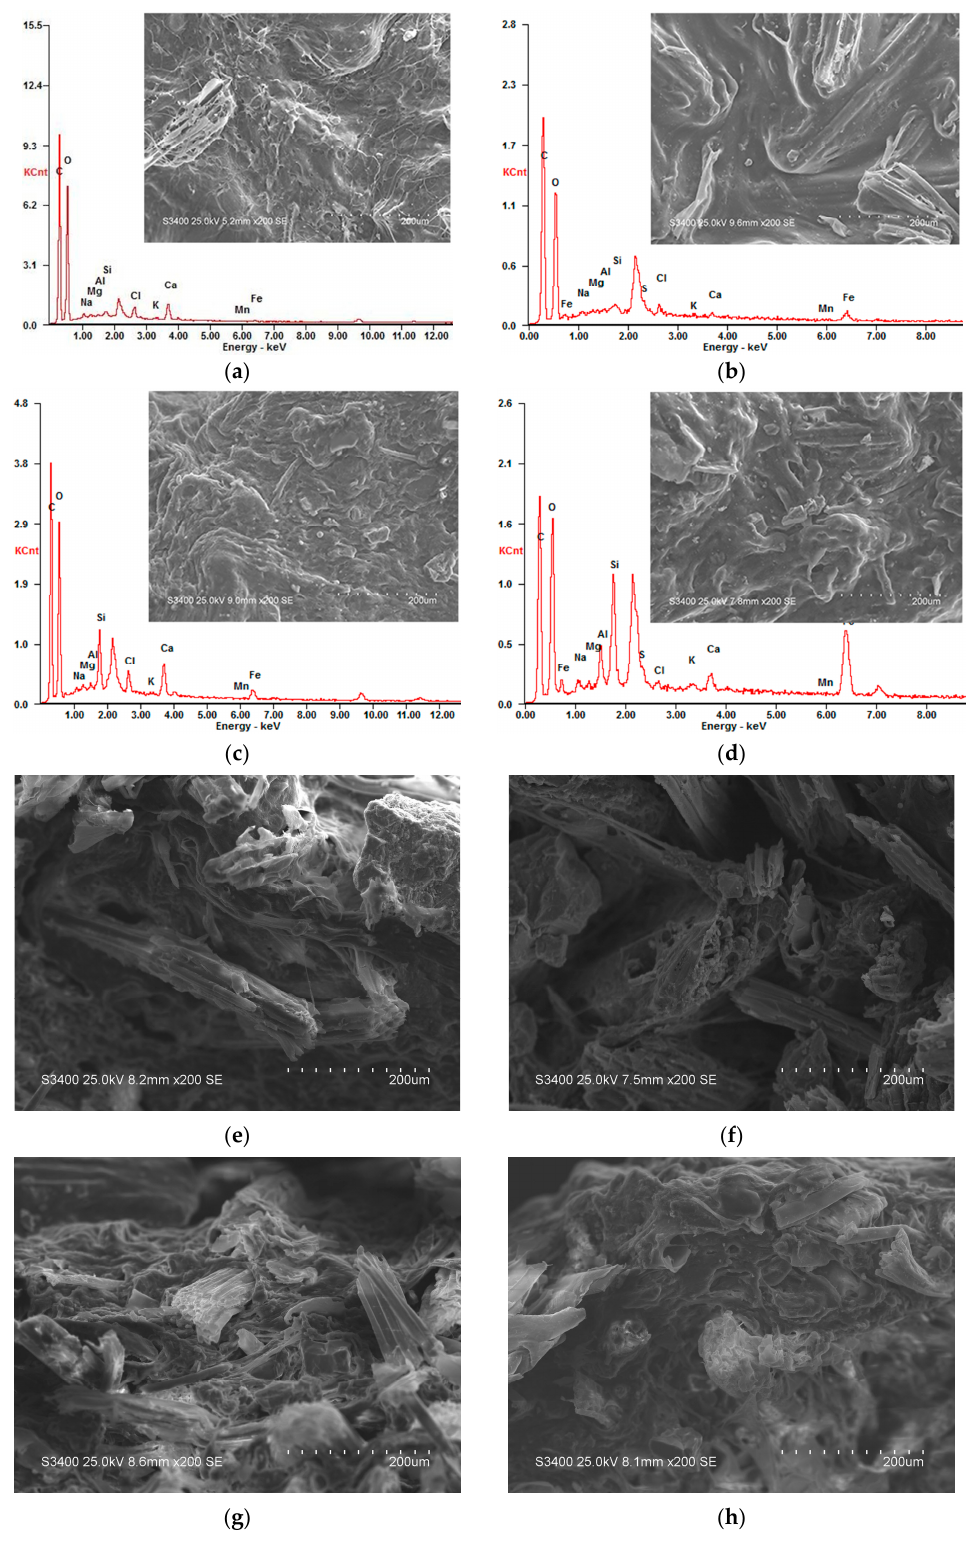
Figure 3. Scanning electron microscopy/energy-dispersive X-ray spectroscopy ( SEM/EDS) images of particle surface (section) before and after treating AMD. ( a ) Particle No.1 surface; ( b ) Particle No.1 surface after treating AMD; ( c ) Particle No.2 surface; ( d ) Particle No.2 surface after treating AMD; ( e ) Particle No.1 section; ( f ) Particle No.1 section after treating AMD; ( g ) Particle No.2 section; ( h ) Particle No.2 section after treating